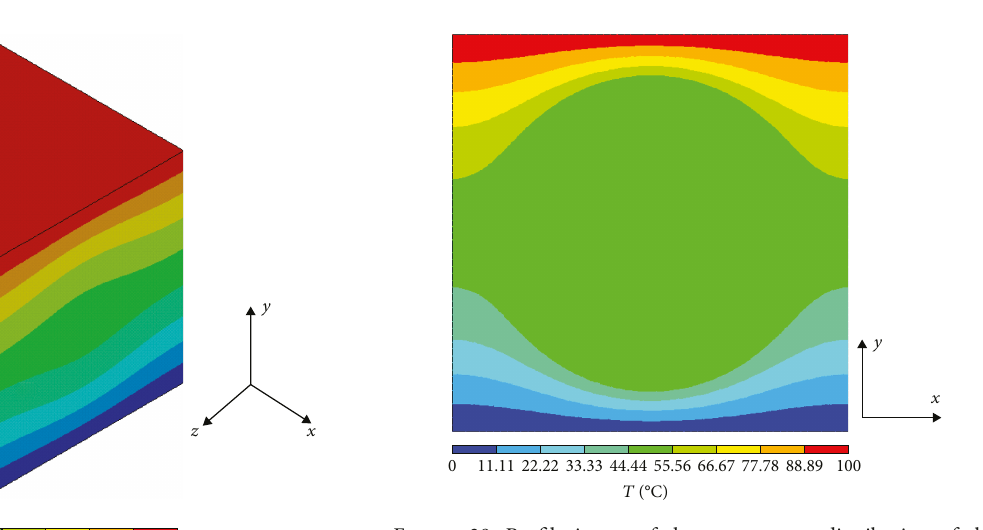
Figure 28: Pro fi le image of the temperature distribution of the microsphere carbonization model.